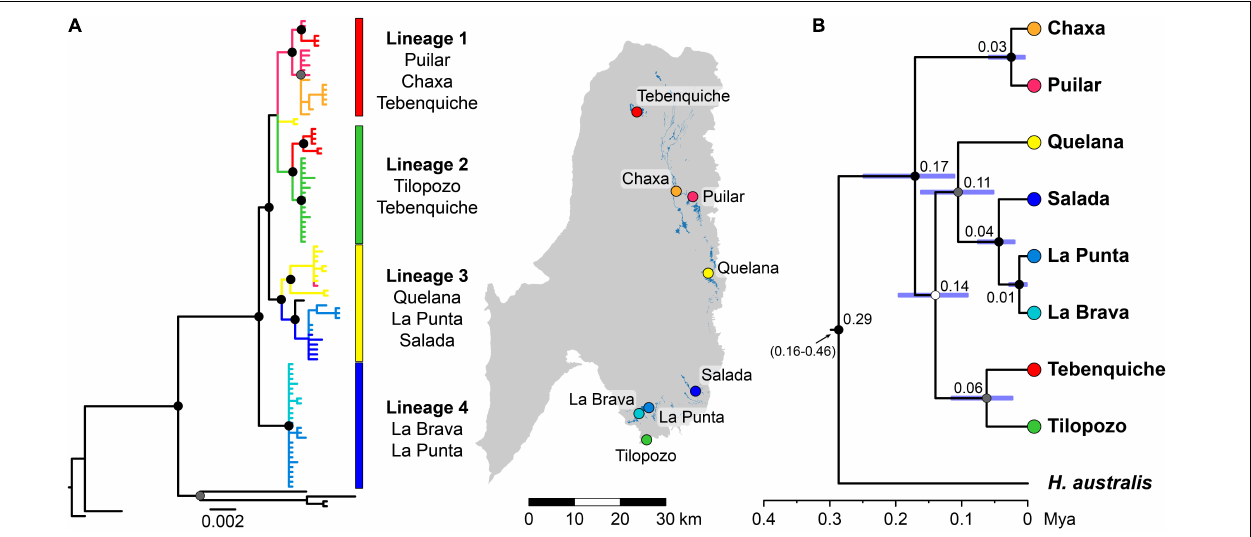
FIGURE 2 | Phylogenetic relationships of Heleobia populations of the Atacama Saltpan (A) Bayesian inference tree of Heleobia using three mitochondrial loci (12S, 16S, and COI). Tree is rooted with different species of Heleobia of the Atacama Desert and southern Altiplano (see full results in Supplementary Figure 1 ). (B) Maximum clade credibility (MCC) tree of Heleobia obtained from StarBEAST2 analysis based on nuclear and mitochondrial loci (H3, ITS1 and ITS2; 12S, 16S, and COI). Heleobia australis (Buenos Aires, Argentina) was used as outgroup. Mean divergence time estimates are shown with 95% highest posterior density (HPD; blue bars). For both phylogenetic estimations (A,B) , black, gray, and white filled circles indicate nodes that were recovered with posterior probability (PP) ≥ 0.95, 0.75– < 0.95, and < 75, respectively. Sampling sites are color-coded (as in other figures) to assist comparisons. TABLE 1 | Indices of genetic diversity obtained from partial sequences of the COI gene for each sampling system of the Atacama Saltpan. System Latitude (S) Longitude (W) N S K